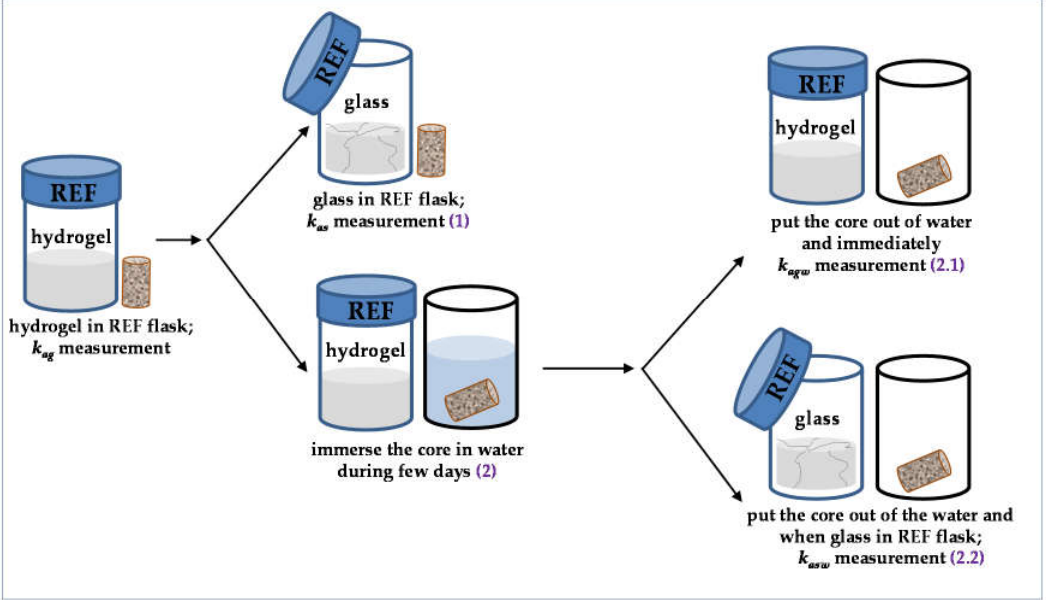
Figure 3. Scheme of the different air permeability measurements performed in the first set of experiments. Values of k ag and k agw were measured when solgel inside the porous cores became hydrogel whereas k as and k asw values were measured when the hydrogel inside the porous cores became glass. The reference flask (REF) was used to determine the time required for the solgel to become hydrogel and eventually glass.